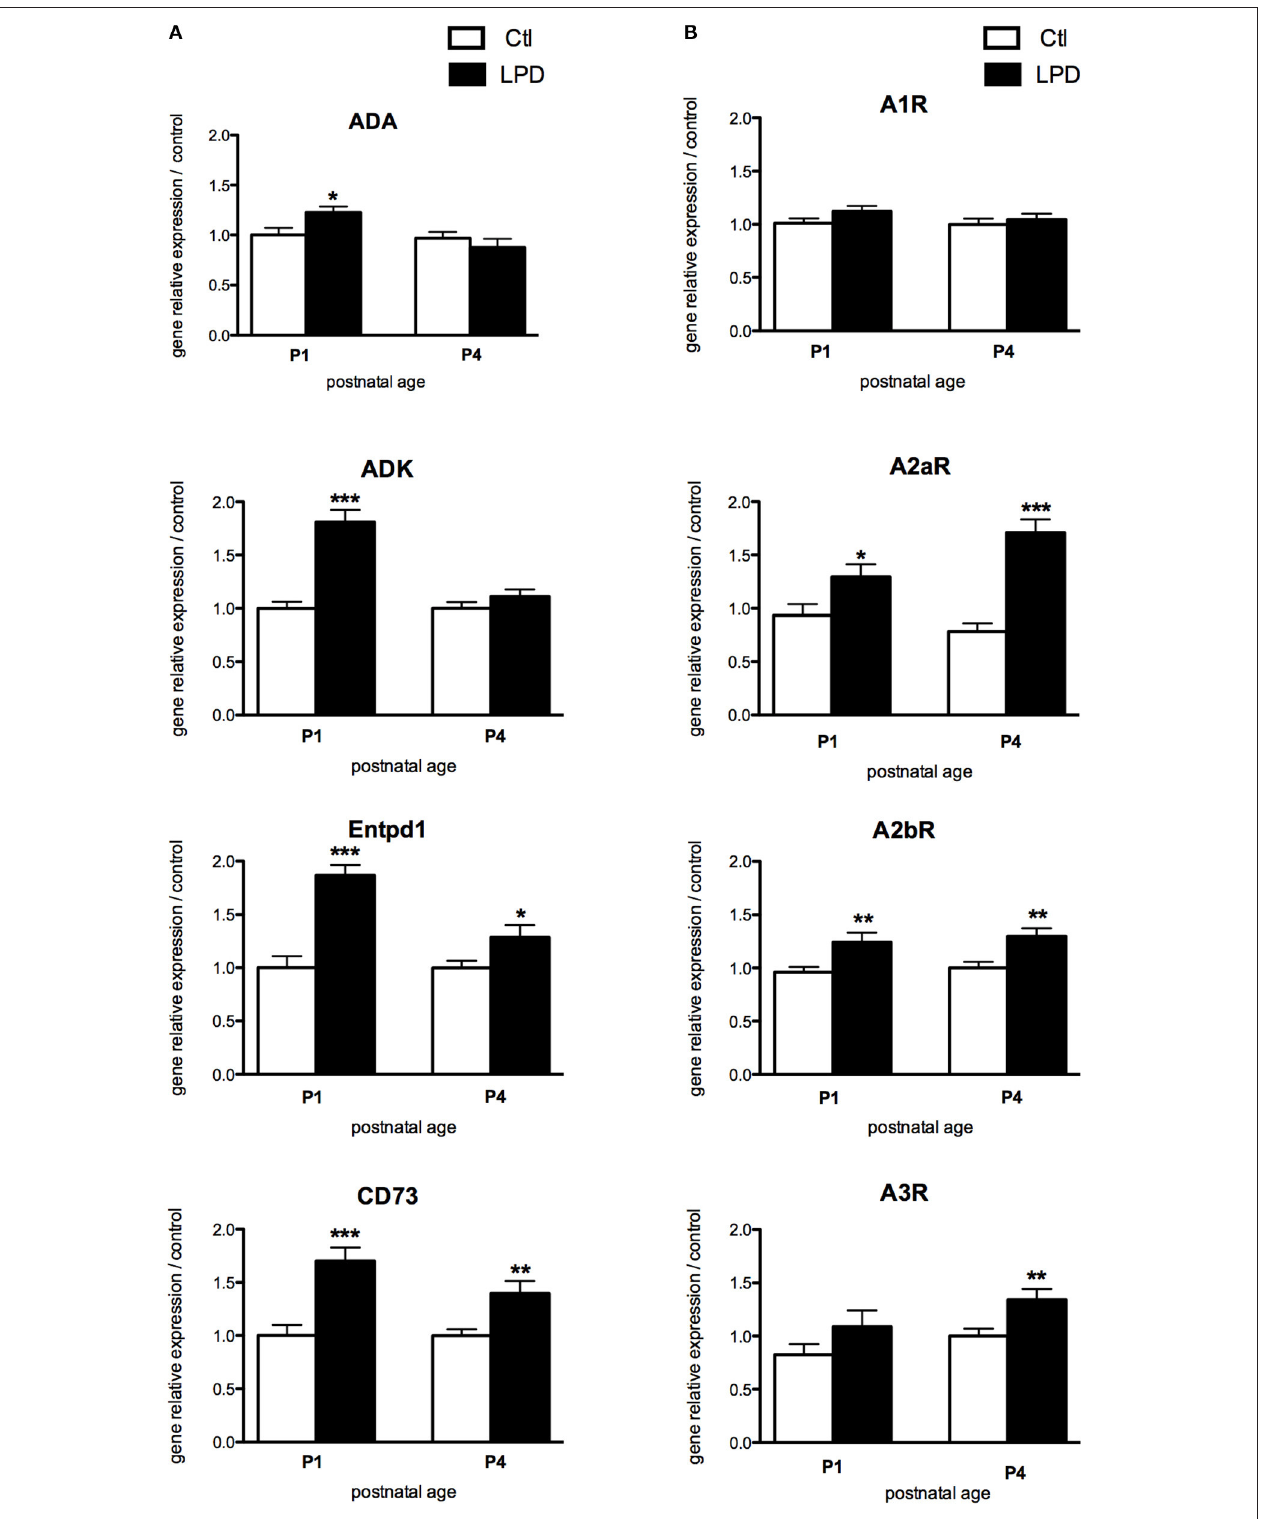
FIGURE 2 | Comparisons of gene expression of enzymes involved in the production of adenosine (A) and its receptors (B) in animals exposed to LPD (black bars) and in control animals (white bars) in prefrontal cortex. Data are shown as relative expression of control values normalized to 1 (* p < 0.05, ** p < 0.01, *** p < 0.001, using unpaired Student’s t -test). ADA, adenosine deaminase; ADK, adenosine kinase; Entpd1, ectonucleoside triphosphate diphosphohydrolade-1; CD73, cluster of differentiation 73; A1R, adenosine A1 receptor; A2aR, adenosine A2a receptor; A2bR, adenosine A2b receptor; A3R, adenosine A3 receptor.